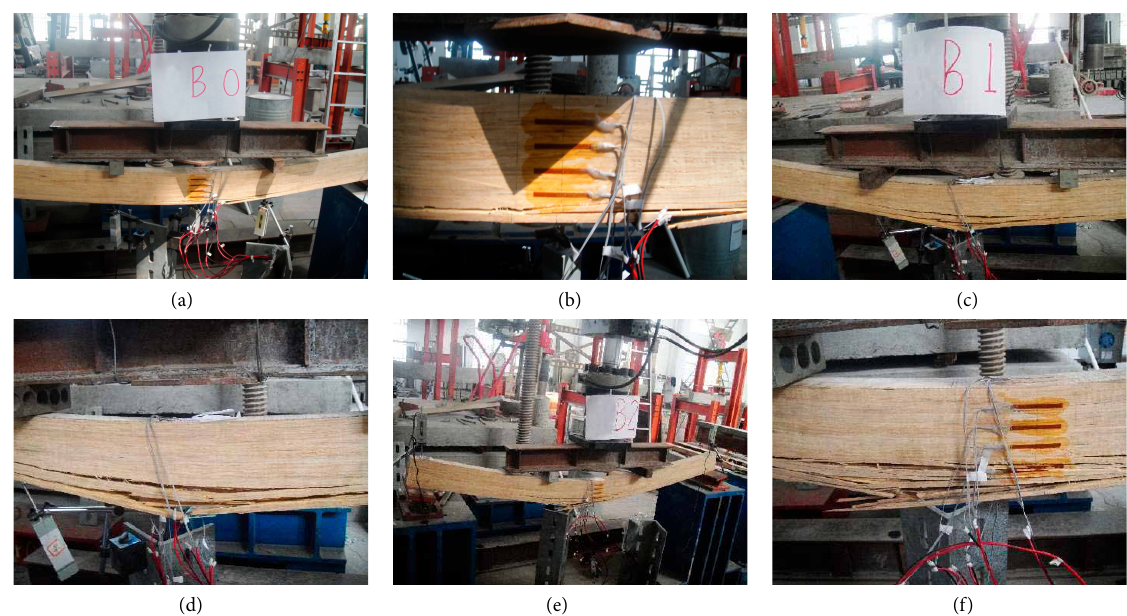
Figure 8: Failure photos for the second series: specimen B0: (a) overall view of, and (b) local view; specimen B1 (c) overall view and (d) local view; specimen B1 (e) overall view, and (f) local view.